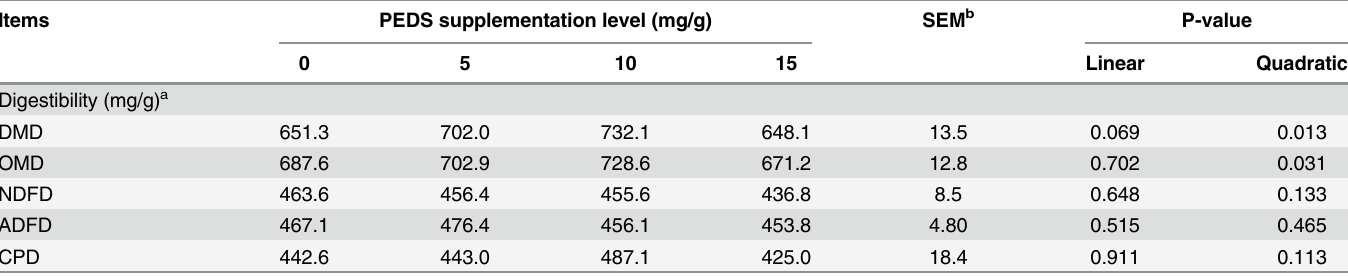
Table 2. The effects of PEDS on the digestibility of the fermentation substrate in continuous-culture (mg/g)